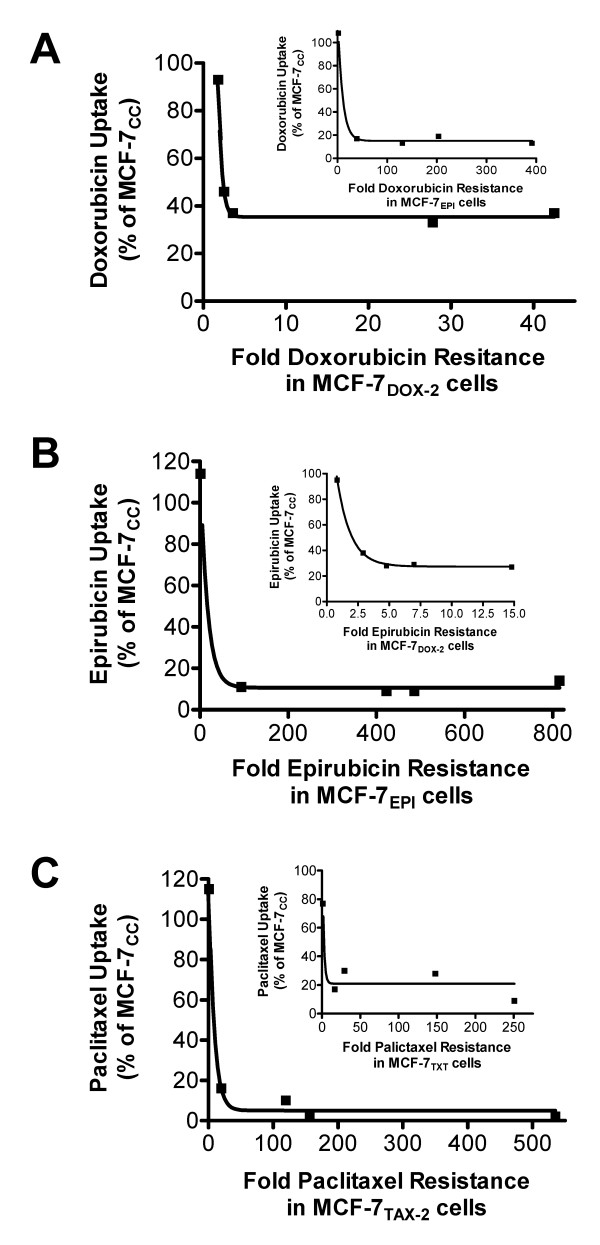
Relationship between drug uptake and drug resistance in various drug-resistant cell lines. Sensitivity of MCF-7TAX-2, MCF-7TXT, MCF-7DOX-2, and MCF-7EPI cells (at various selection doses) to doxorubicin, epirubicin, or paclitaxel was measured using a clonogenic assay and compared to MCF-7CC cells to determine fold drug resistance (the resistance factor). Uptake of doxorubicin, epirubicin, and paclitaxel was also measured in the drug-resistant cell lines and expressed relative to uptake into MCF-7CC cells. The relationships between doxorubicin (A), epirubicin (B), or paclitaxel (C) uptake and fold resistance to various drugs in the cell lines were then plotted.